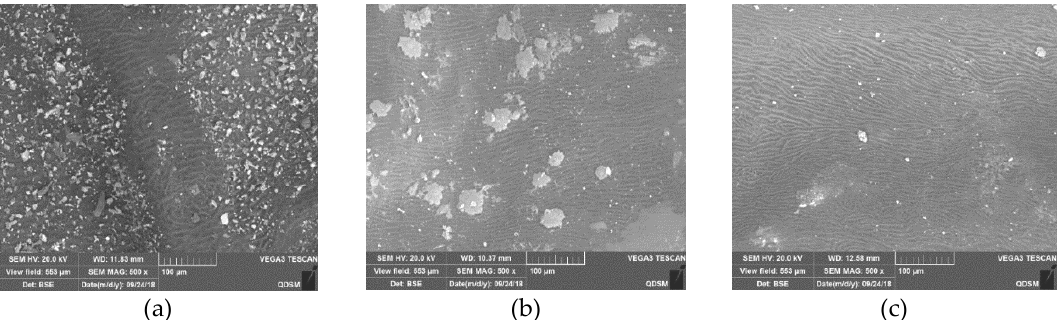
Figure 9. Surface microstructures of Chinese wolfberry fruits. ( a ) Ionic wind; ( b ) without ionic wind; ( c ) control.